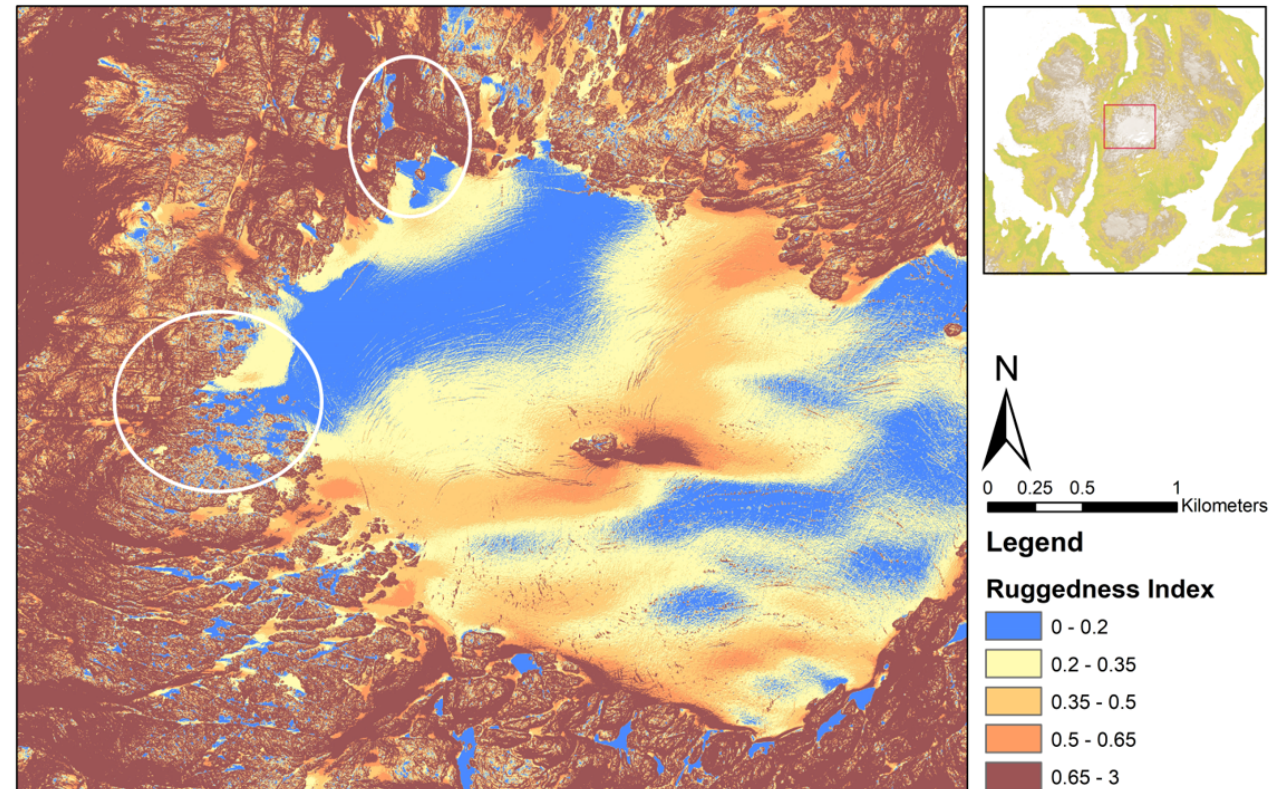
Figure 3. Seilandsjøkulen and its surrounding rocky areas. The applied terrain ruggedness index makes areas of the glacier without much movement and crevasses visible. The white ovals at the western and northern fringes of the glacier mark areas with ice patches which are non-moving and small scale, thus granting a higher likelihood of preserved archaeological artifacts. The blue areas in the southern part of the glacier are meltwater lakes. WGS 84/UTM Zone 34N.